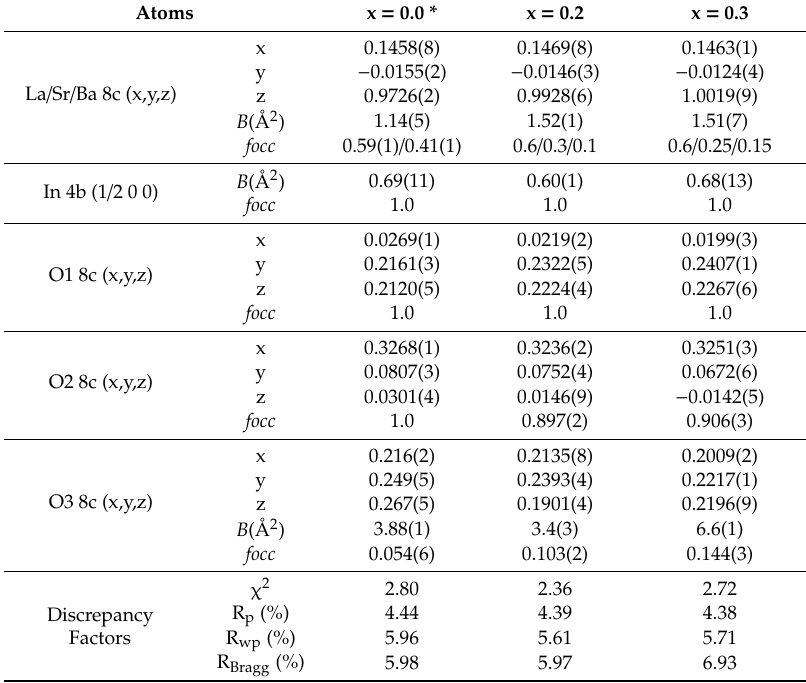
* From Reference [23].